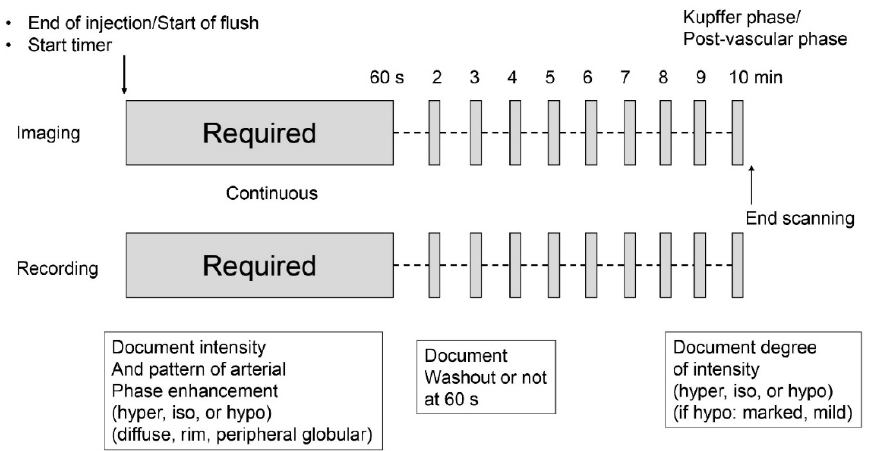
Figure 1. Sonazoid Contrast-Enhanced Ultrasound protocol.